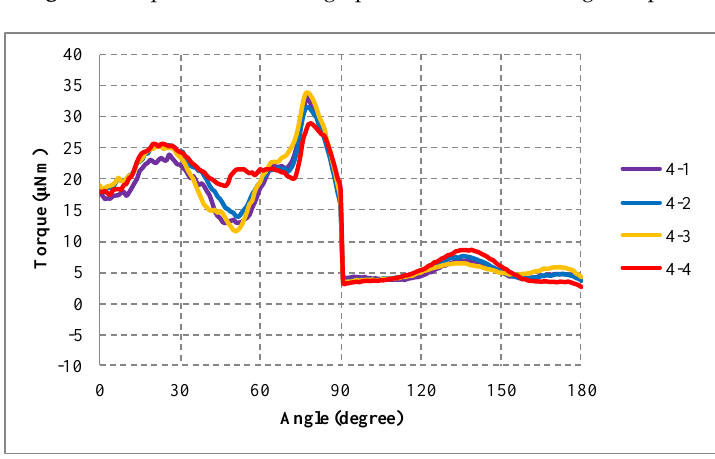
Figure 9. Step 4: Detailed design process of the rotor magnetic pole.